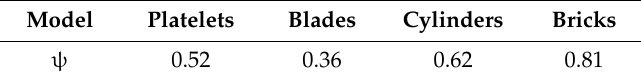
Table 2. Sphericity ( ψ ) or the